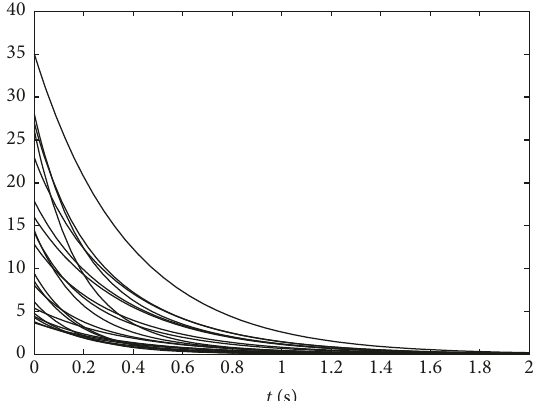
‖̃𝐴 𝑋(𝑡)̃𝐵 +̃𝐴 𝑋(𝑡)̃𝐵 −̃𝐶‖ 1 1 2 2 𝐹 synthesizedby